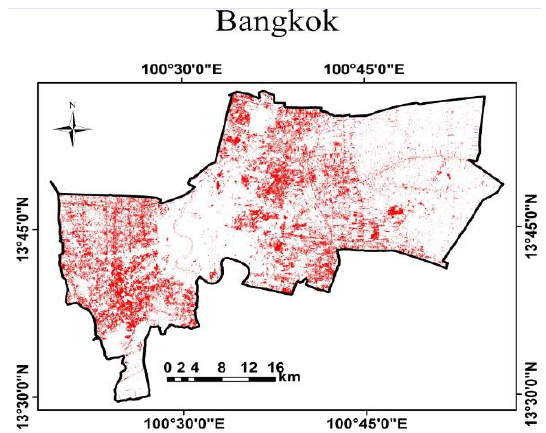
Figure 3. Urban expansion map – red pixels indicate new urban areas formed between 1987 and 2017 The gridded UN adjusted GPWv4 population density values for years 2000 and 2015 were used to derive a population density change map over the 15 years, which was then resampled to Landsat data spatial resolution of 30 m for maintaining spatial uniformity in intra-city analysis.